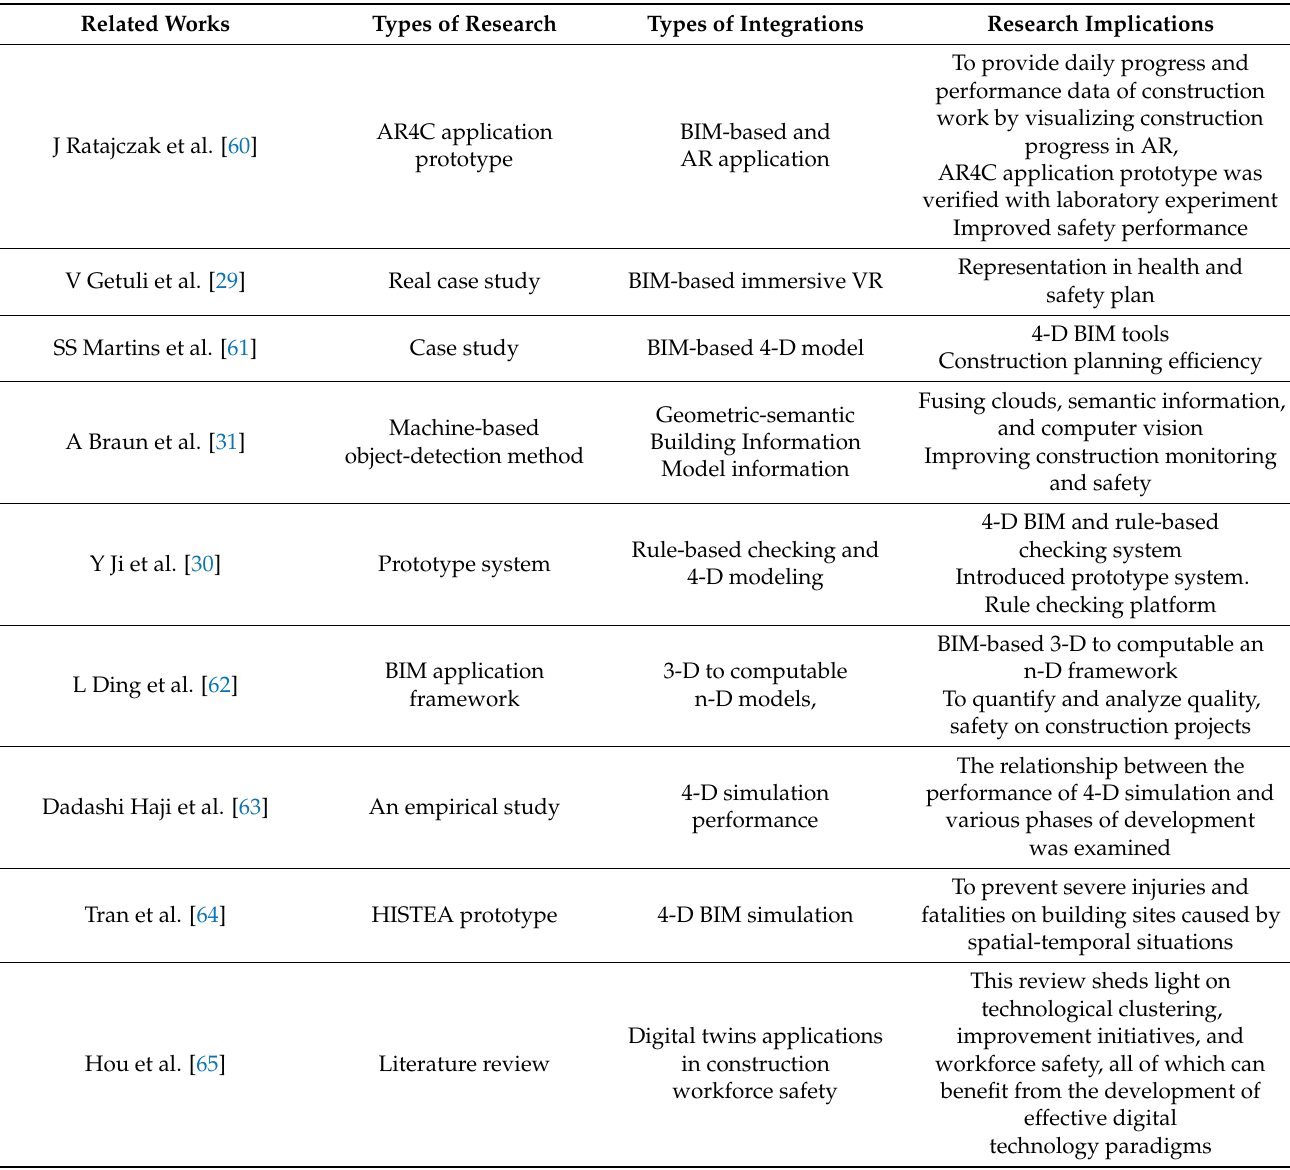
Table 1. Overview of related